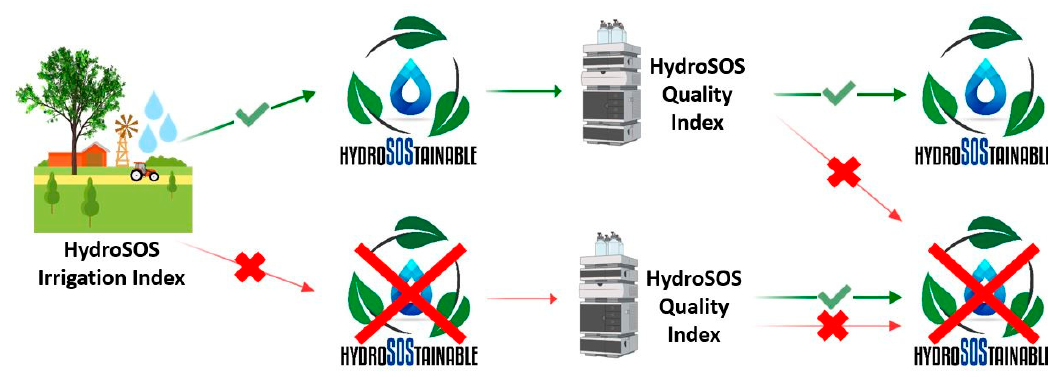
Figure 1. HydroSOStainable index: two complementary indices.